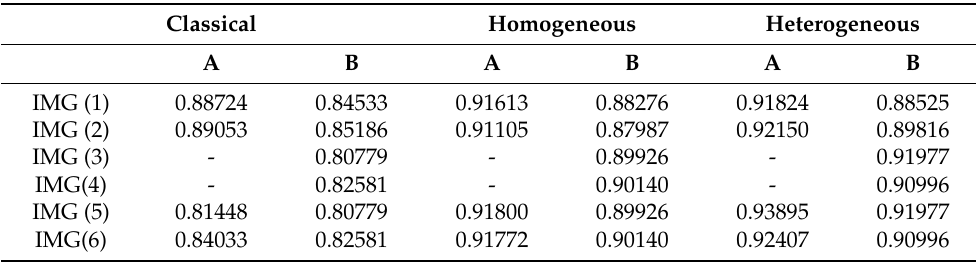
Table 5. Average performance measures for the selected images in Figure 6, columns (A) refer to supervised evaluation; columns (B) refer to unsupervised evaluation. Classical Homogeneous